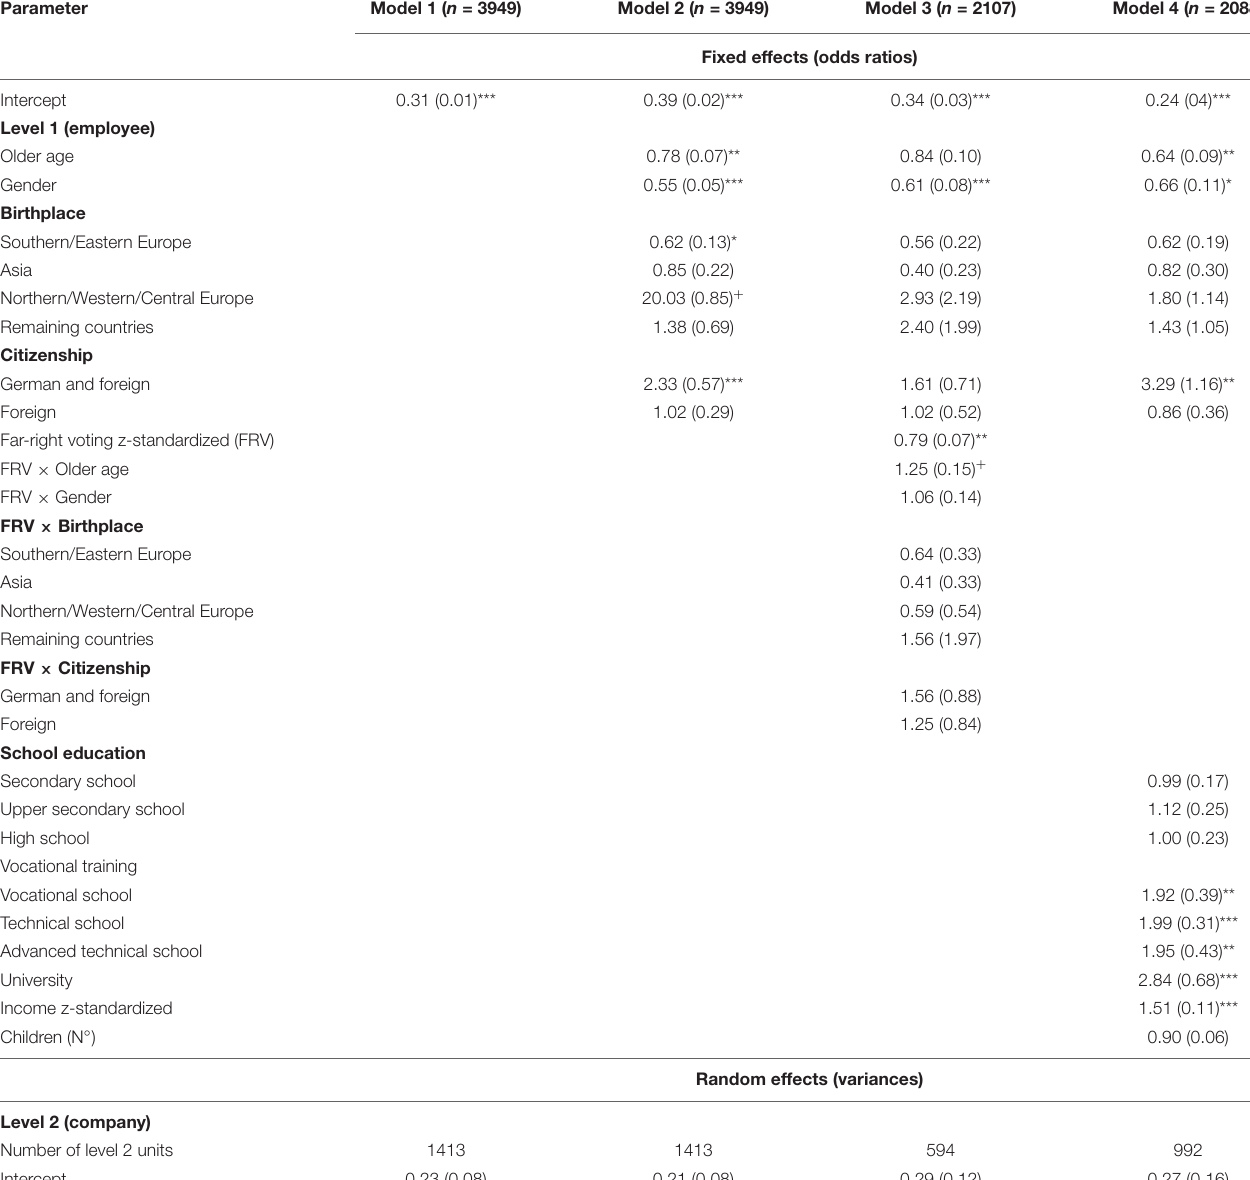
TABLE 3 | Mixed multilevel analyses for active sourcing with fixed effects for employees and random intercepts for company as second level.